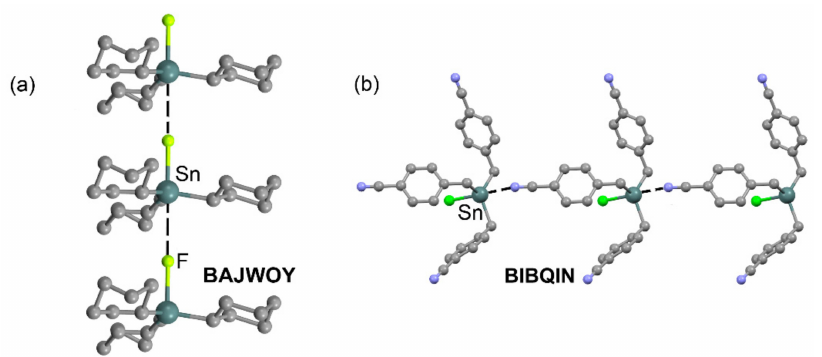
Figure 5. Ball-and-stick representation of BAJWOY ( a ) and BIBQIN ( b ) structures exhibiting